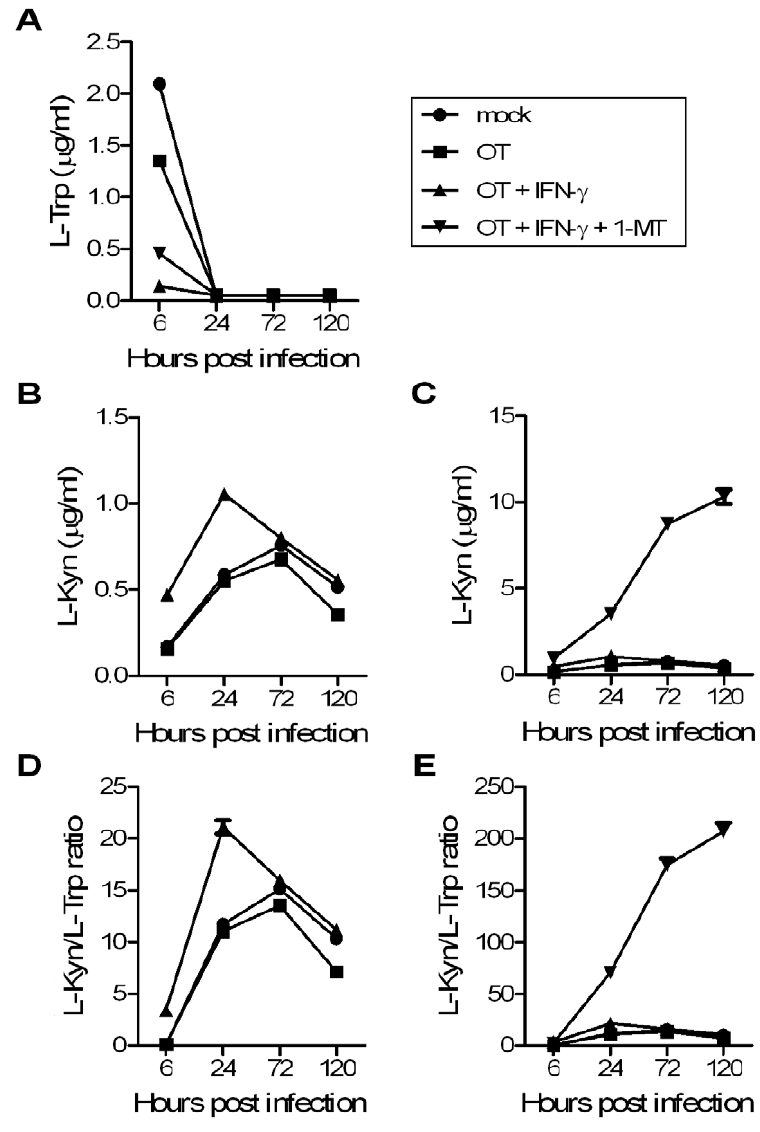
Figure 3. Assessment of IDO1 activity in OT-infected THP-1 cultures. Before being infected with OT, THP-1 cells were treated with IFN- c alone, IFN- c combined with 1-MT, or neither. Mock-infected THP-1 cells were used as a control. Levels of L-Trp (A) and L-Kyn (B, C) were measured in culture supernatant at 6, 24, 72, and 120 hours p.i.. IDO1 activity was reflected by the ratio of L-Kyn to L-Trp (D, E) at each indicated time point. Figure 3B and 3D represent the same dataset as Figure 3C and 3E respectively, but those treated with IFN- c combined with 1-MT were excluded for clearer illustration. Means 6 SEM from triplicate cultures are shown. Note: L-Trp concentration fell below a detectable level at 24, 48 and 72 hours p.i.; therefore, the lower limit of detection of L-Trp, 0.05 ng/ml, was used in the calculation of L-Kyn/L-Trp ratio for these time